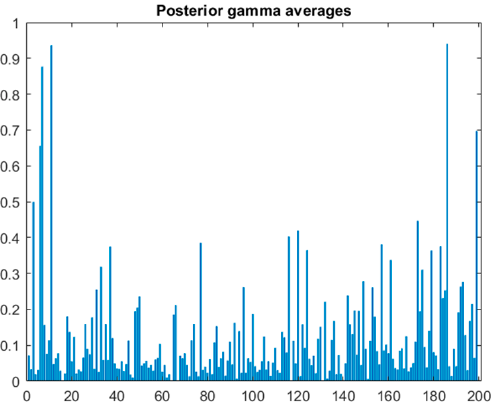
Figure 15. Bayes model 2 histogram of the out-of-sample relative rank of the best IS strategy.